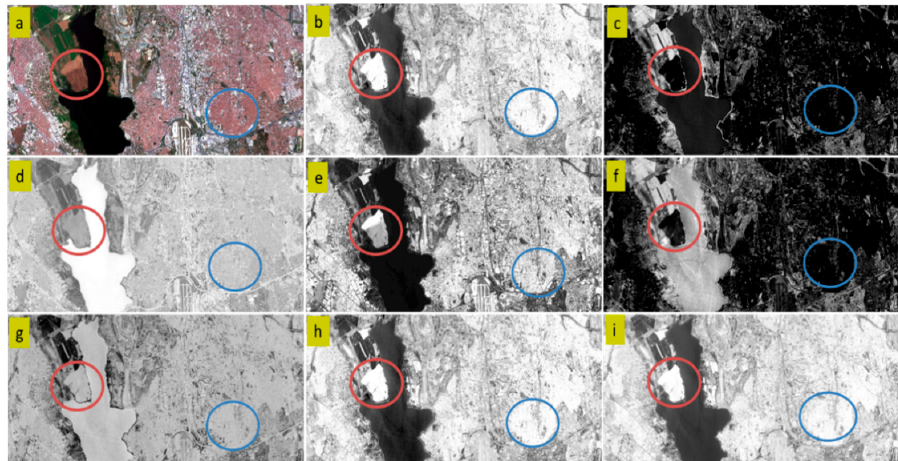
Figure 3. Images of ( a ) Sentinel-2A RGB; ( b ) normalized difference built-up index (NDBI); ( c ) built-